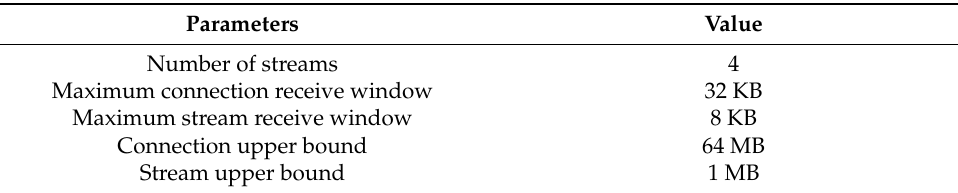
Table 2. Parameter setting for a four-stream